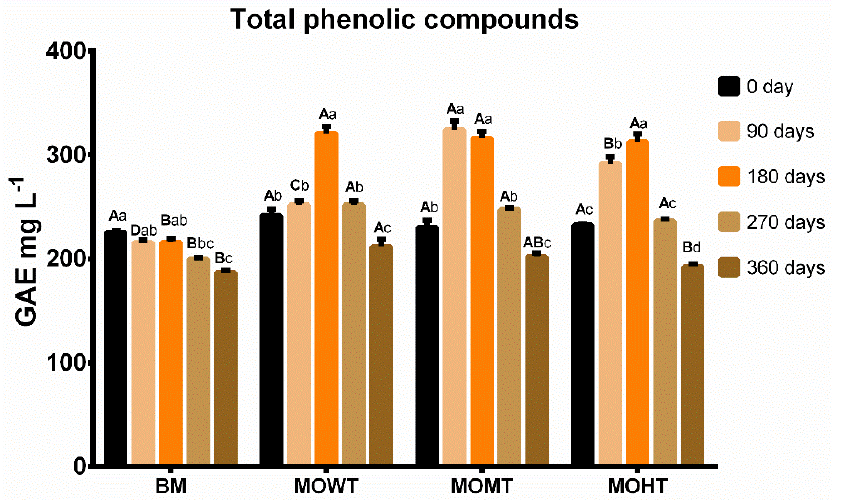
Figure 1. Composition of total phenolics (mg GAE L − 1 ) of meads aged with oak ( Quercus ) chips. Data are presented as means ± SEM ( n = 5). Lowercase letters indicate significant differences over time within the same experimental group ( p ≤ 0.05). Capital letters indicate significant differences between experimental groups within the same time ( p ≤ 0.05). GAE: gallic acid equivalent; BM: base mead; MOWT: mead aged with oak chips without toasting; MOMT: mead aged with oak chips at medium toasting; MOHT: mead aged with oak chips at high